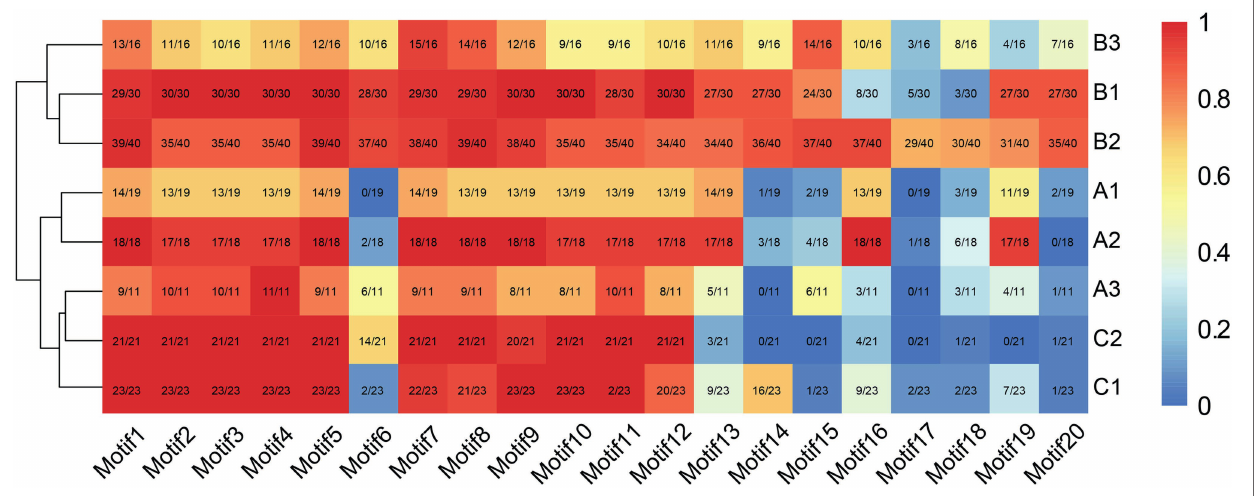
FIGURE 4 | The distribution of each motif structure in different subgroups. The red indicates more occurrences, blue indicates fewer